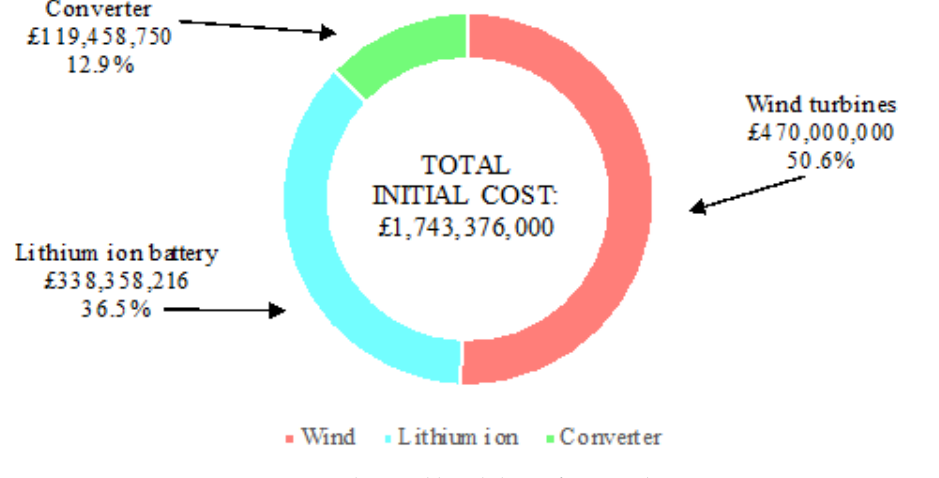
Figure 11. Initial capital breakdown for Manchester.